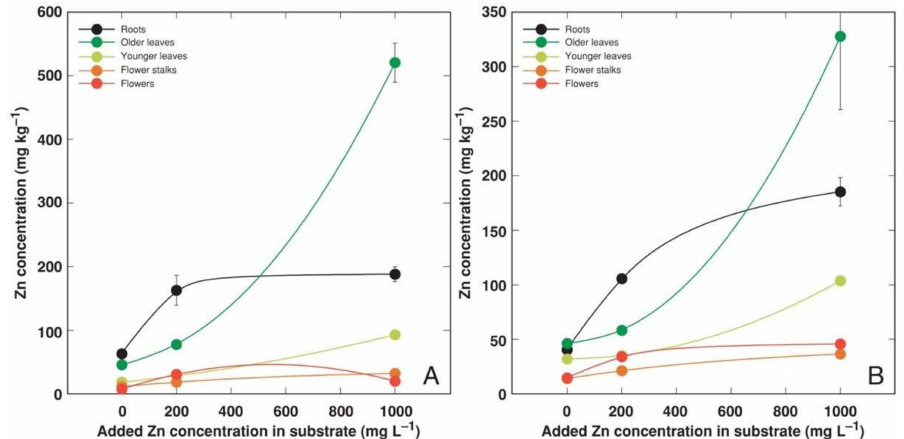
Figure 8. Effect of added Zn concentration in soil on Zn concentration in different parts of Armeria maritima plants of accession AM1 ( A ) and AM2 ( B ) after cultivation for 9 weeks. Data are means ± SE from 3